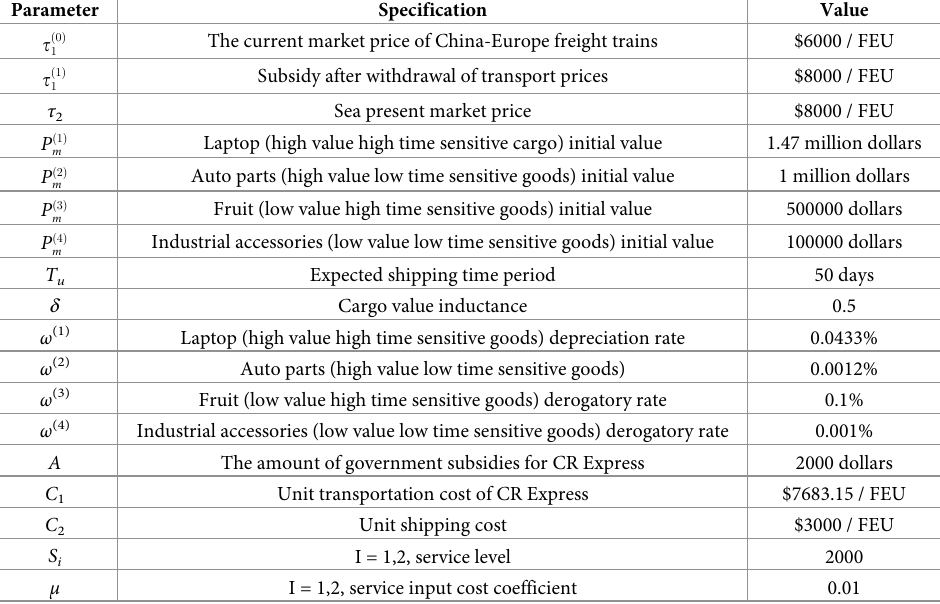
Table 5. Data for evolutionary game